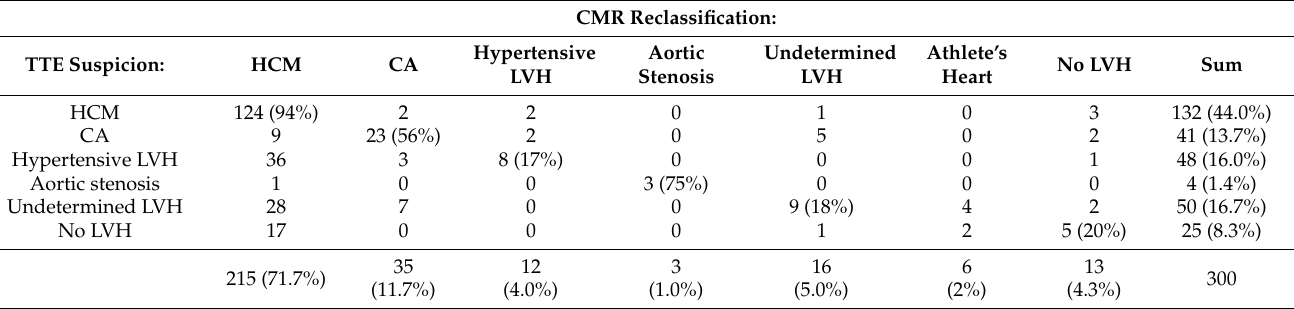
Table 2. Comparison between echocardiographic suspicion and CMR final diagnosis in the different groups; in the grey boxes, the matches for each group, n (%). LVH: left ventricular hypertrophy. CMR Reclassification: